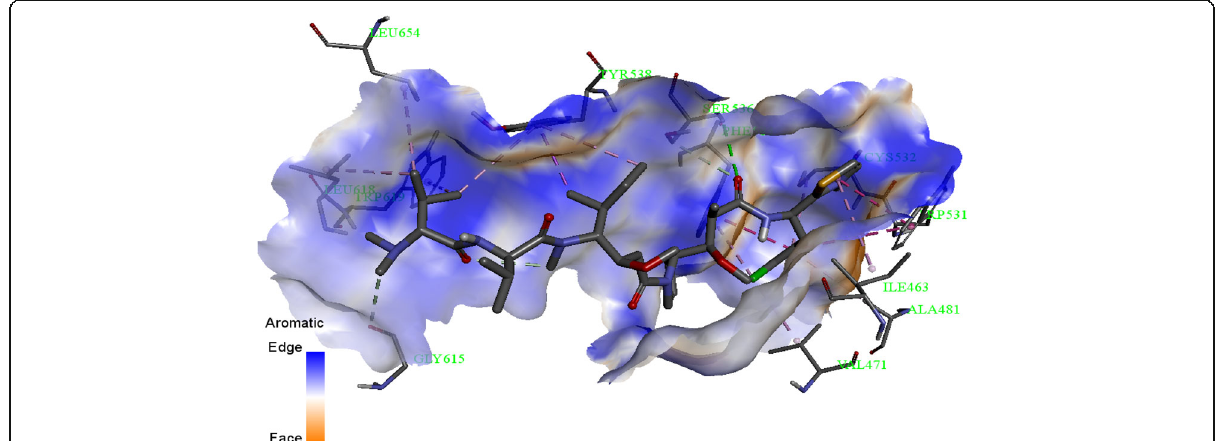
Fig. 6 3D diagram of the interaction between N2 with V600E-BRAF